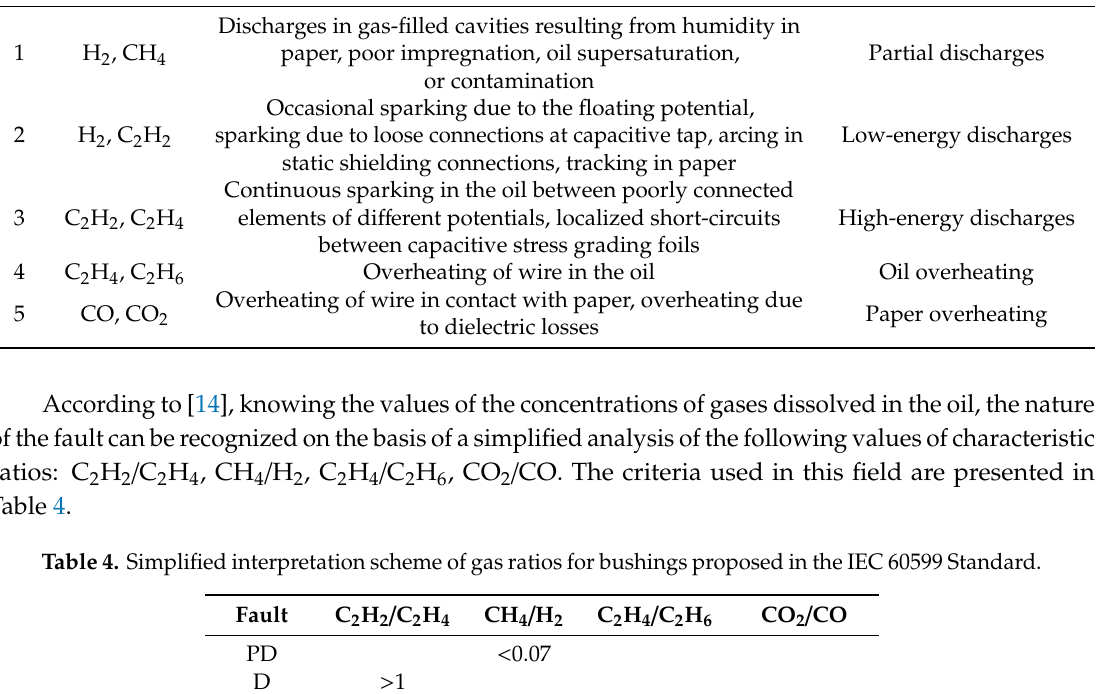
Table 3. Fault types detected in bushings on the basis of the analysis of gases dissolved in oil [16,17]. No.